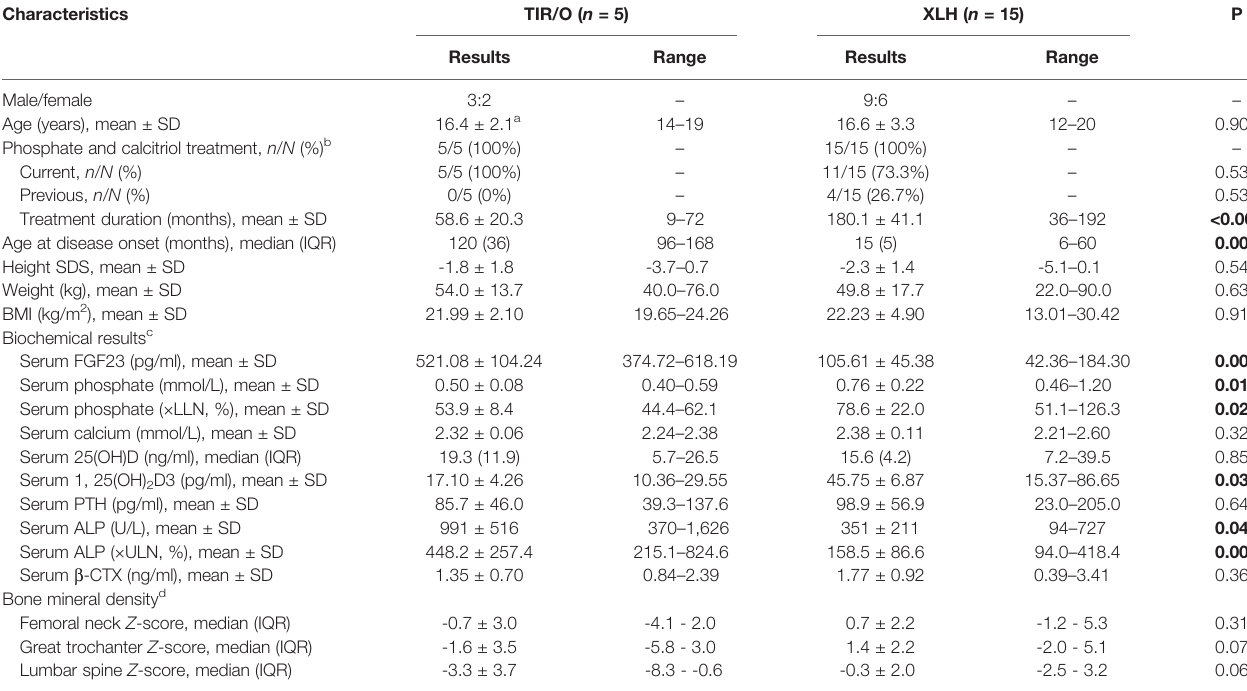
TABLE 1 | Comparison of general features, biochemical characteristics, and bone mineral densities between TIR/O and XLH.